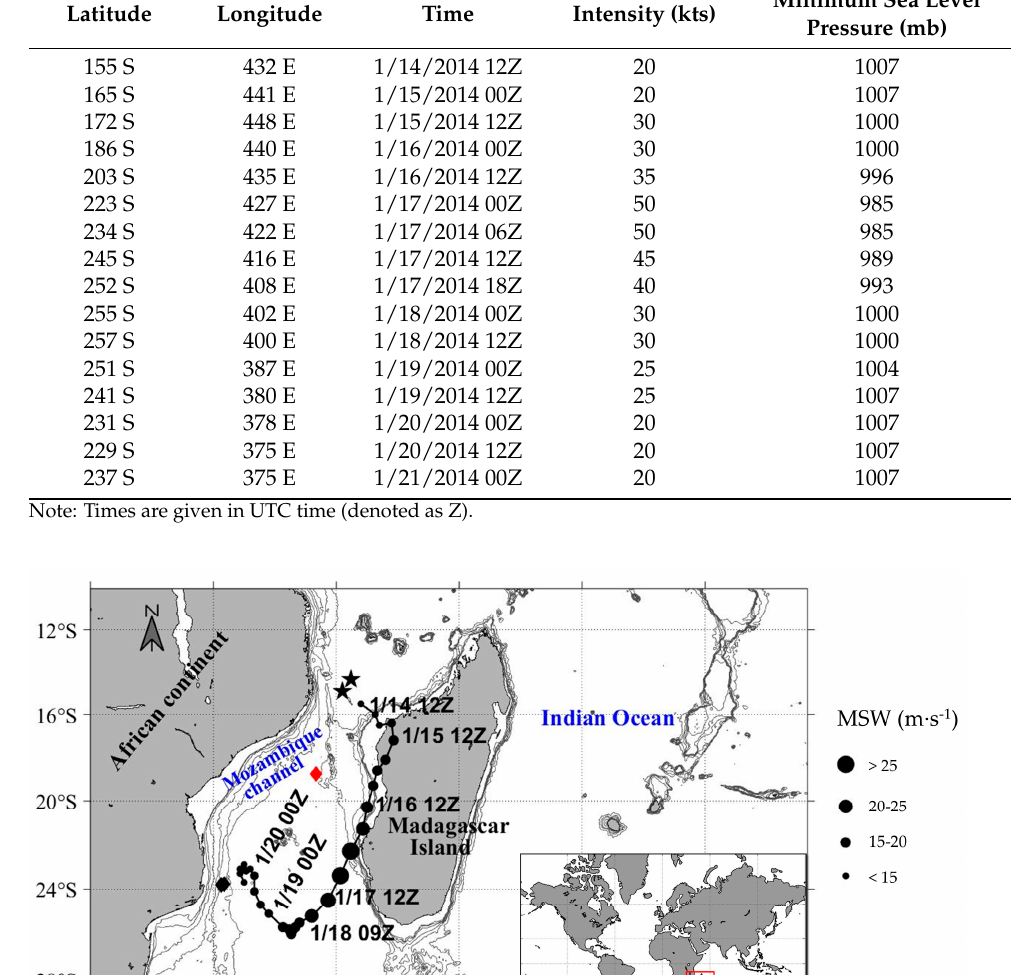
Table 1. Position, time and intensity of TS Deliwe.